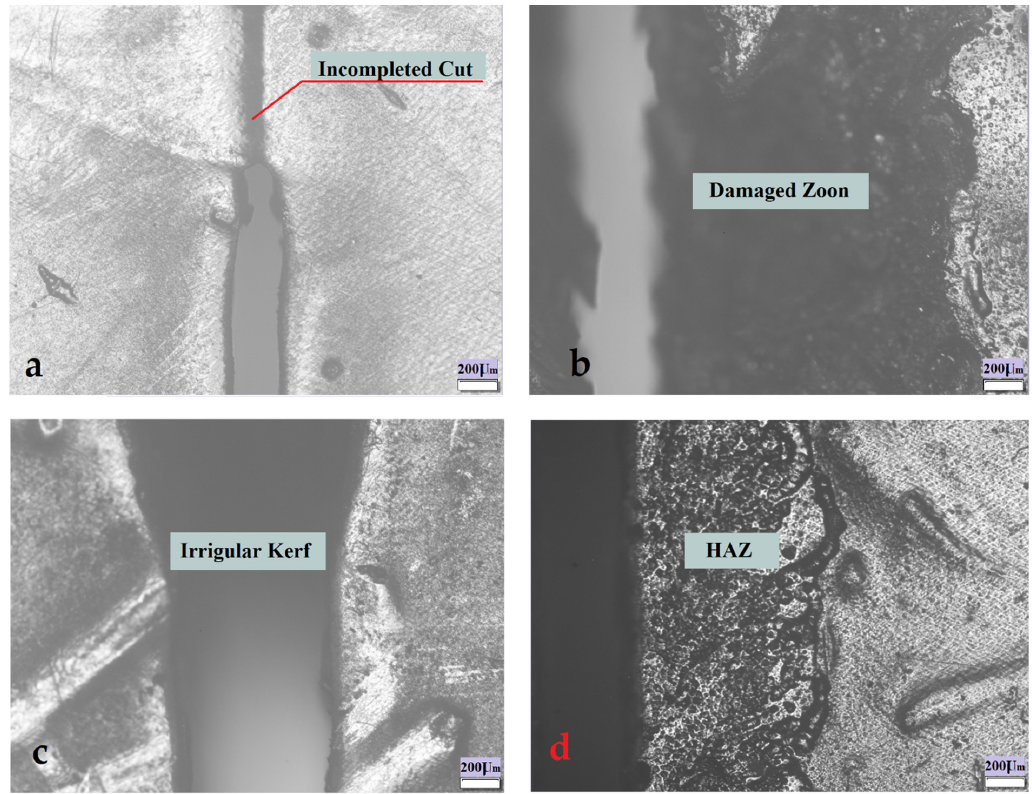
Figure 2. ( a ) Incomplete cut. ( b ) Damage at the cutting zone. ( c ) Irregular kerf. ( d ) High extension of the heat-affected zone (HAZ).